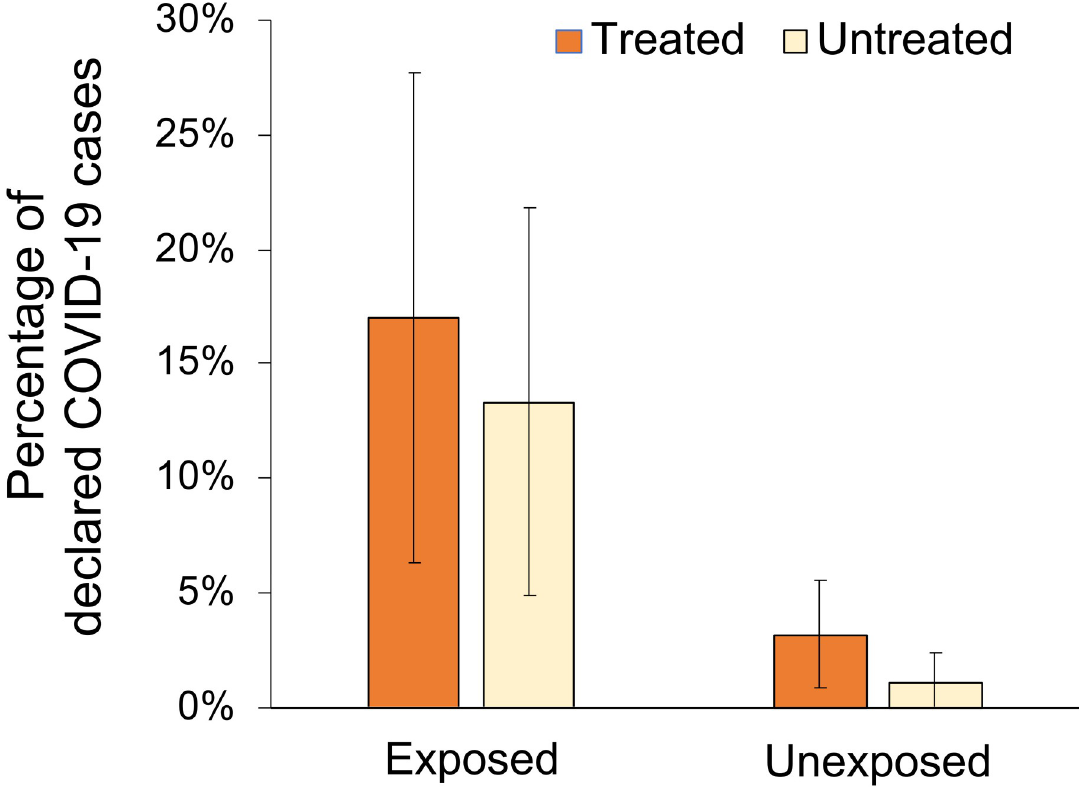
Fig 1. Percentage of declared COVID-19 cases according to treatment status and community exposition. Treated group refers to patients regularly taking chloroquine and its derivatives. Exposed are those individuals declaring a COVID-19 positive case in a close family member or flatmate. Error bars depict the 95% confidence